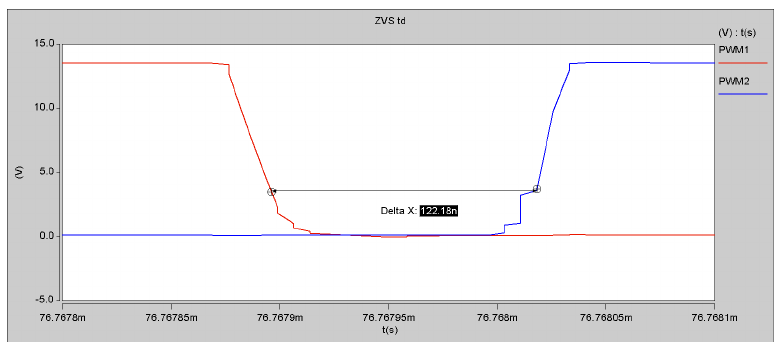
Figure 14. The dead time of phases A and B.